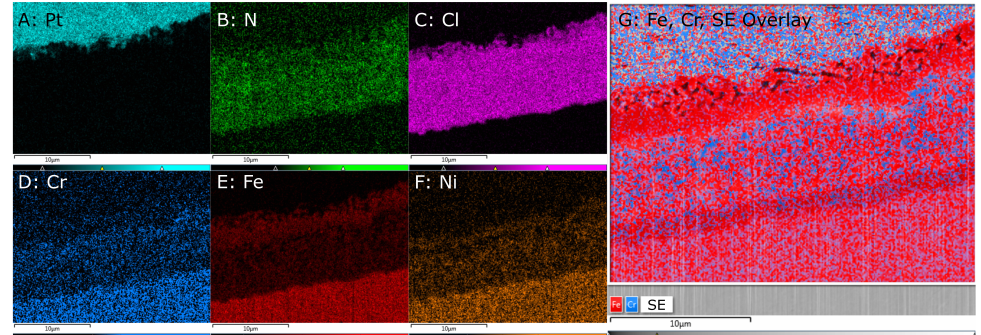
Figure 6. XEDS maps of the FIB-cut sub-surface zone of AISI-316L sample TX activated by 15 N 2 H 4 Cl reagent pyrolysis at 563K for 2.7ks.